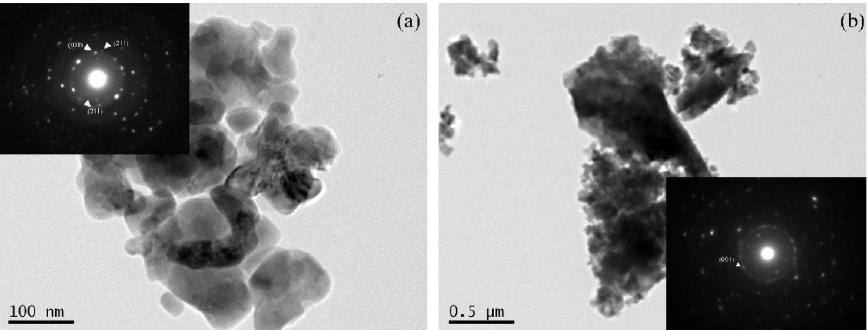
Figure 12. TEM photomicrographs: ( a ) quartz’s and moganite’s crystallites and reflections in SAED patterns (inset); and ( b ) quartz’s crystallites and reflections in the SAED pattern (inset). Due to similarities in quartz and moganite d-spacings, there are not discrete moganite domains.